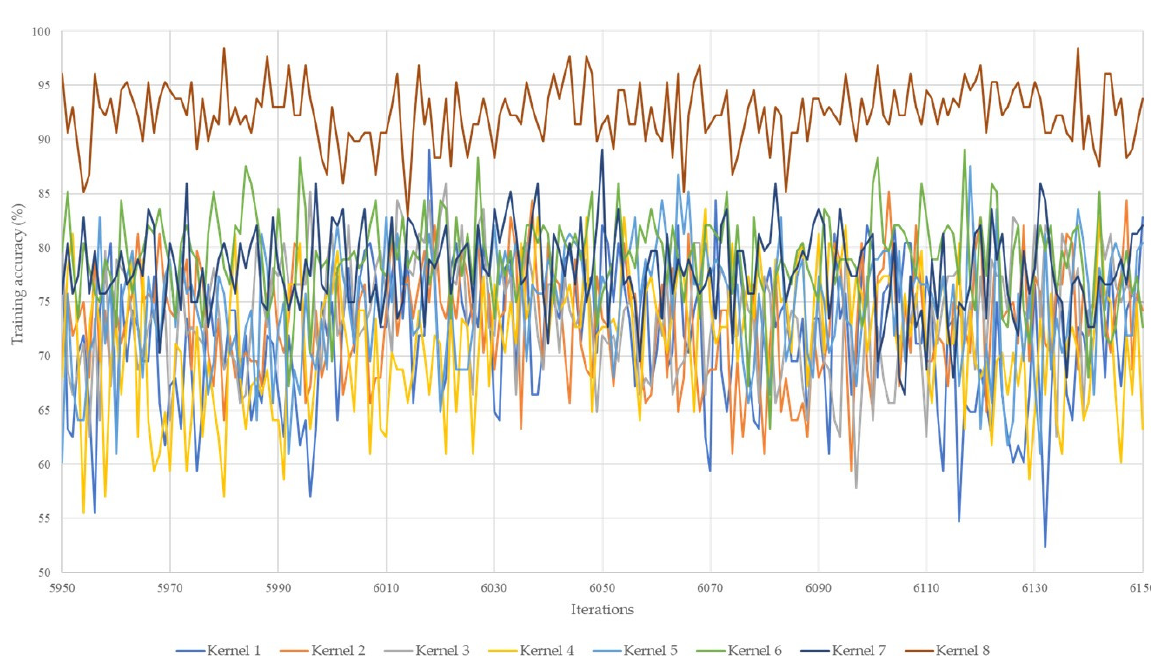
Figure 7. Training accuracy learning curve for all kernel sizes. The Y-axis shows the training accuracy in percentage and the X-axis indicates the iterations from iteration 5950 to 6150.